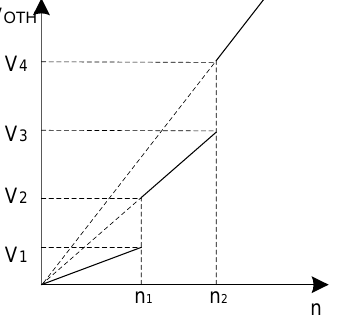
Fig. 2. Dependence of the size of a relation with the changing scheme from the number of temporal